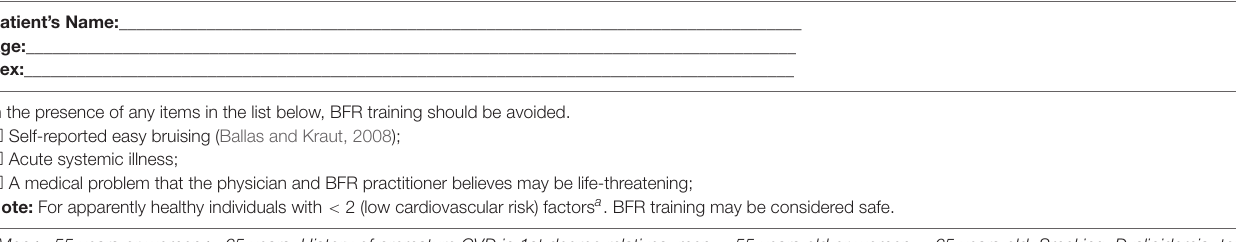
TABLE 7 | Risk factors concerning apparently healthy individuals before